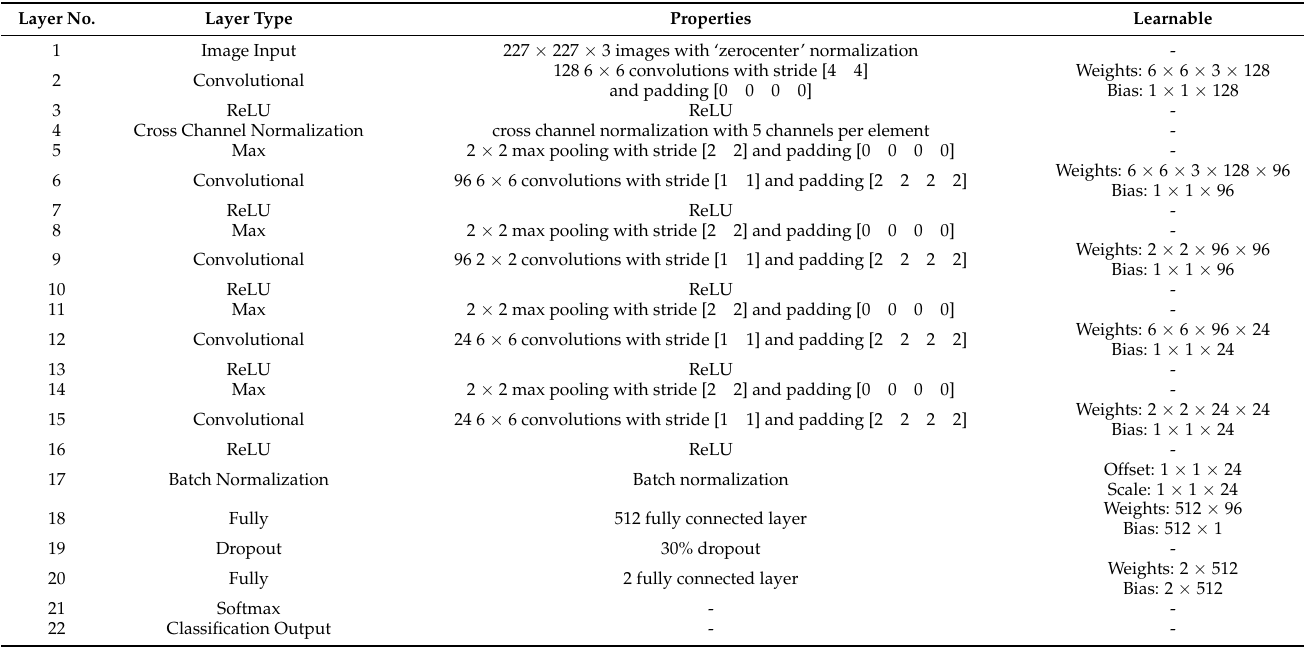
Table 2. Information related to the 22-layer CNN developed from